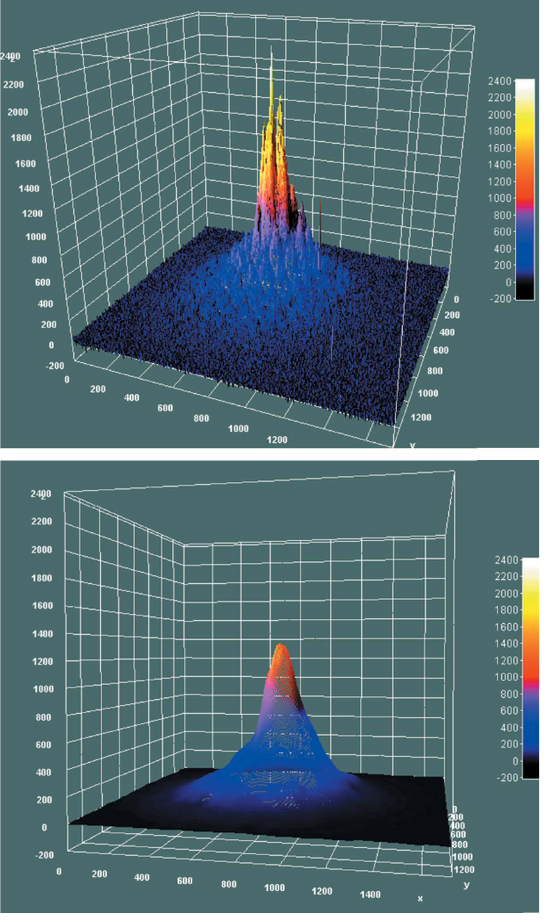
Figure 12 3D beam intensity distribution for PC-246 for the 12 keV primary beam unsmoothed (top) and smoothed (bottom).